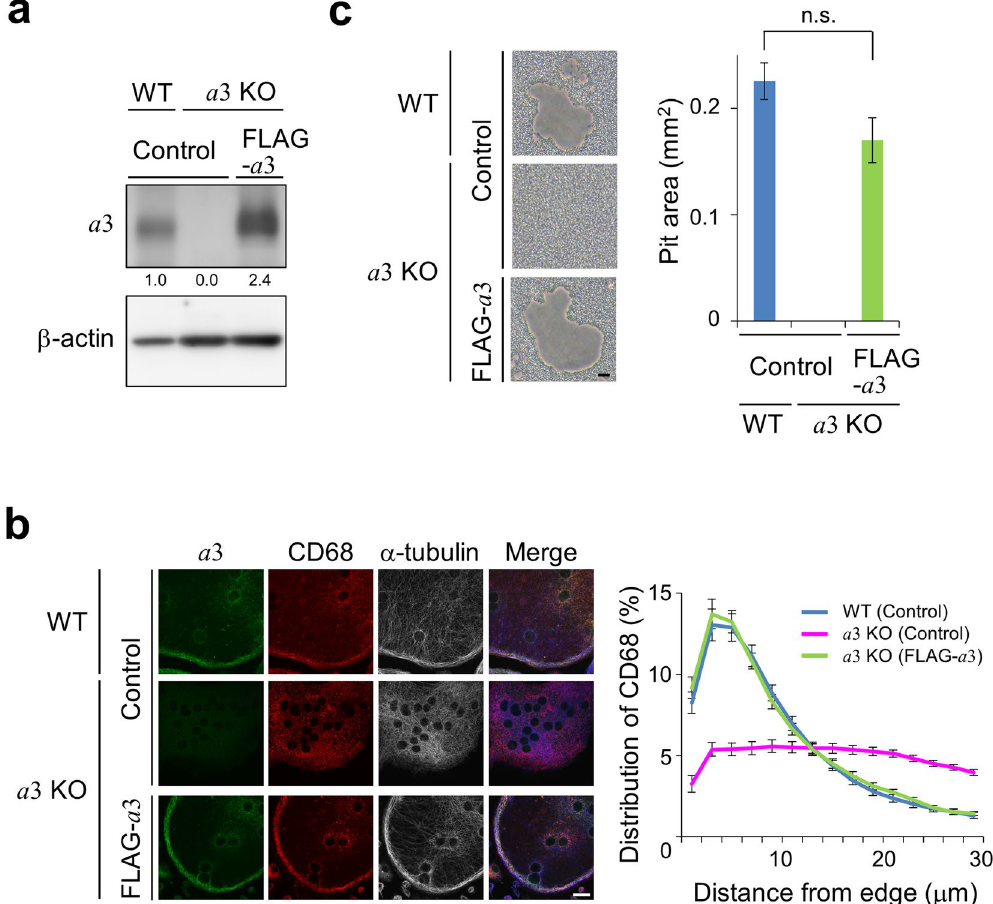
Figure 4. CD68 localisation and resorption activity of a 3-knockout osteoclasts expressing FLAG- a 3. ( a ) Expression of FLAG- a 3 in a 3-knockout osteoclasts. Splenic macrophages obtained from wild-type and mutant mice were transduced with pMX(puro) (empty vector) or pMX-FLAG- a 3 (FLAG- a 3), and cultured with RANKL for 6 days. Thereafter, osteoclast lysates were electrophoresed through an acrylamide gel. Endogenous and FLAG- a 3 were detected with an antibody specific for a 3 (upper panel). β -actin was also detected using corresponding antibody (lower panel). Numbers below blots indicate relative signal intensities of a 3 normalised to that in wild-type cells. ( b ) Effects of a 3 expression on the localisations of CD68 and α -tubulin in mutant osteoclasts. Osteoclasts induced as described in ( a ) were stained with antibodies specific for a 3 (green), CD68 (red) and α -tubulin (white). Representative images are shown together with merged images (Merge). α -tubulin labelling is shown in blue in the merged images. The distribution of CD68 was determined (right panel) as described in Fig. 3e. Blue, magenta and green indicate wild-type, a 3-knockout and FLAG- a 3-expressing a 3- knockout osteoclasts, respectively. Data are means ± s.e.m.; n = 15 cells. ( c ) Resorption activity of mutant osteoclasts expressing FLAG- a 3. Osteoclasts were induced on calcium phosphate-coated dishes and then removed by washing with distilled water. Resorption pits were observed (left panels). The bar indicates 20 μ m. Resorption activity was determined as the area of resorption pits in a field measuring 1.6 mm 2 (right panel). Data are means ± s.e.m.; n.s., not significant (unpaired two-tailed Student’s t -test); n = 9